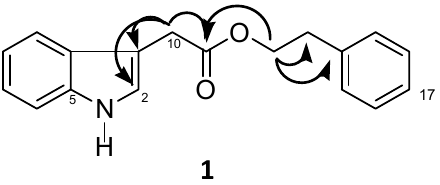
Figure 2. Select g HMBC correlations for 1